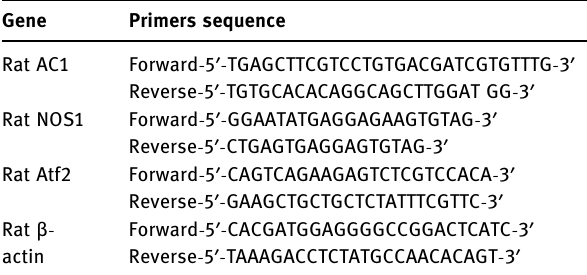
Table A1: Primers and probes for real - time PCR Gene Primers